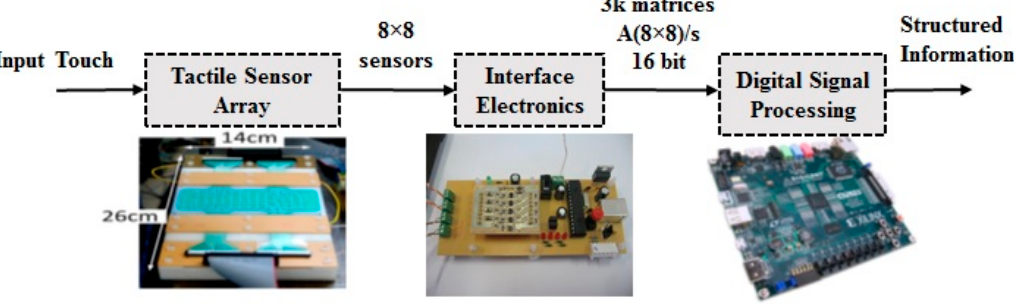
Figure 2. Block diagram of the e-skin system prototype. Courtesy of COSMIC lab at the University of Genova, Italy Genova, Italy (http://www.cosmiclab.diten.unige.it/).